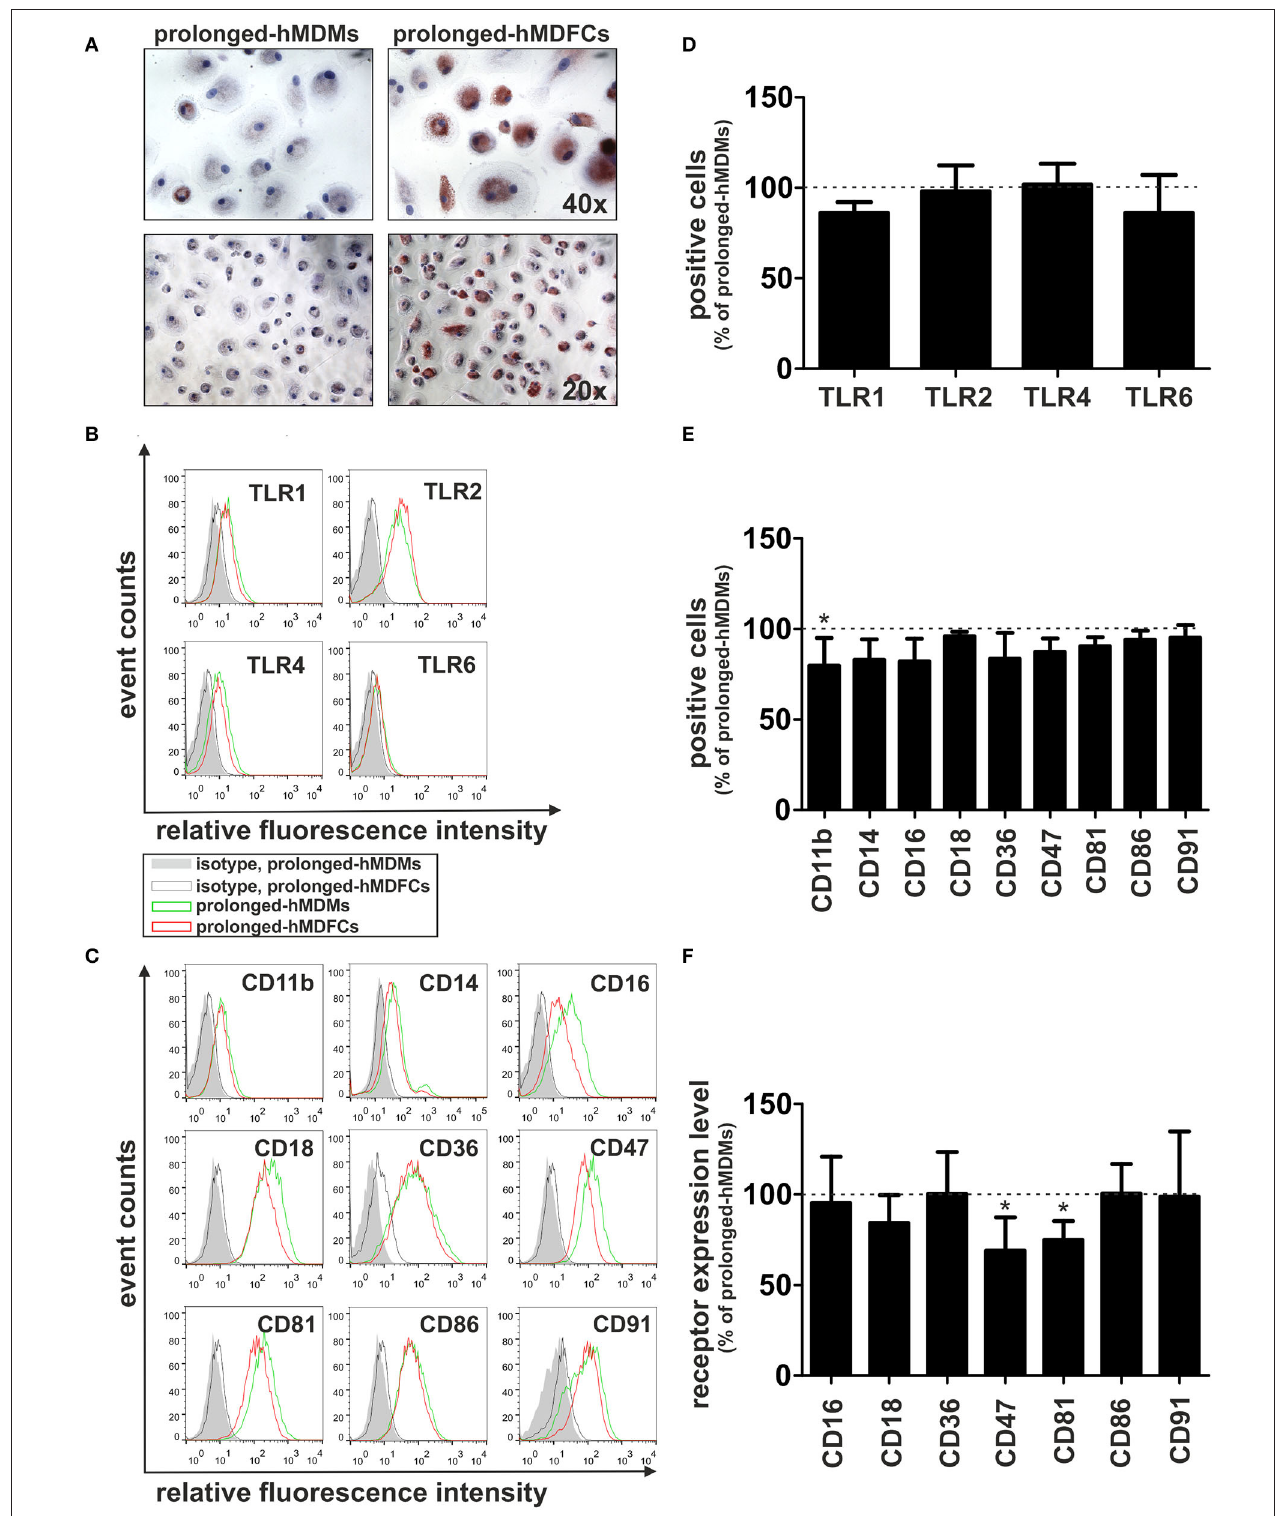
FIGURE 2 | Effect of prolonged culture with oxLDLs on the phenotype of hMDMs. Adherent monocytes were cultured in HS medium for 5 days to allow macrophage differentiation. Since then, the cells were maintained in HS medium (prolonged-hMDMs) or HS medium supplemented with 5 µ g/mL oxLDLs (prolonged-hMDFCs) for the total time period of 30 days. (A) The extent of lipid accumulation was assessed by Oil Red O staining. The cells were counterstained with hematoxylin.